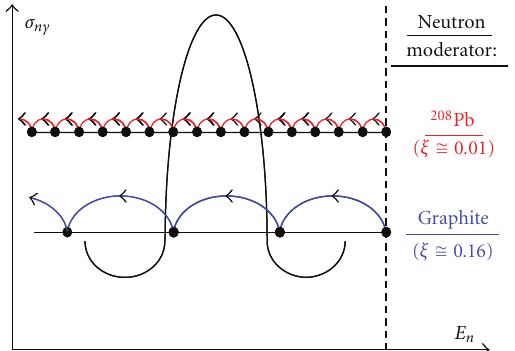
Figure 10: Passage of neutrons through resonance in heavy and light